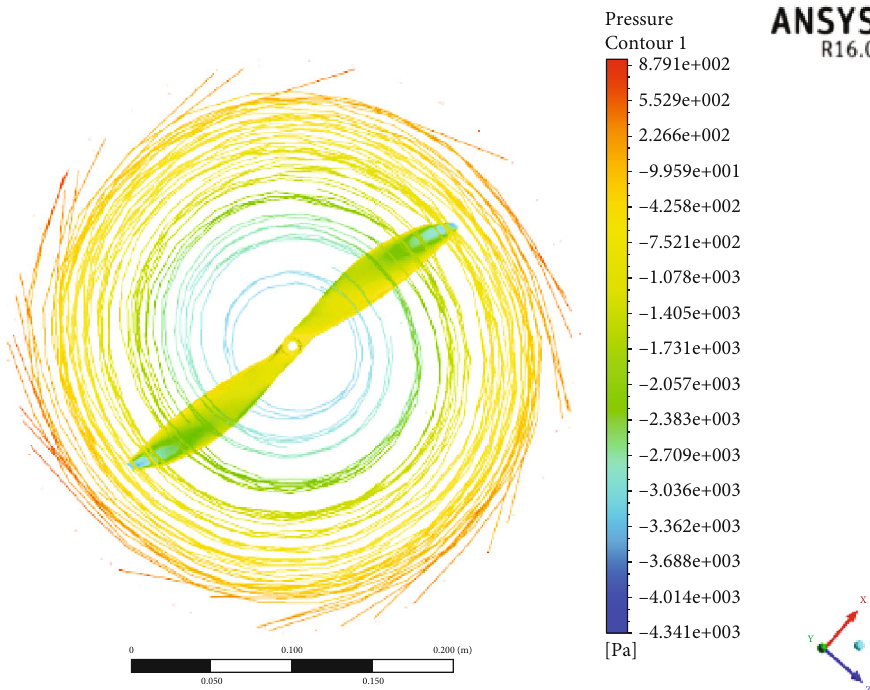
Figure 21: Pressure contour at -50 ° C temperature.